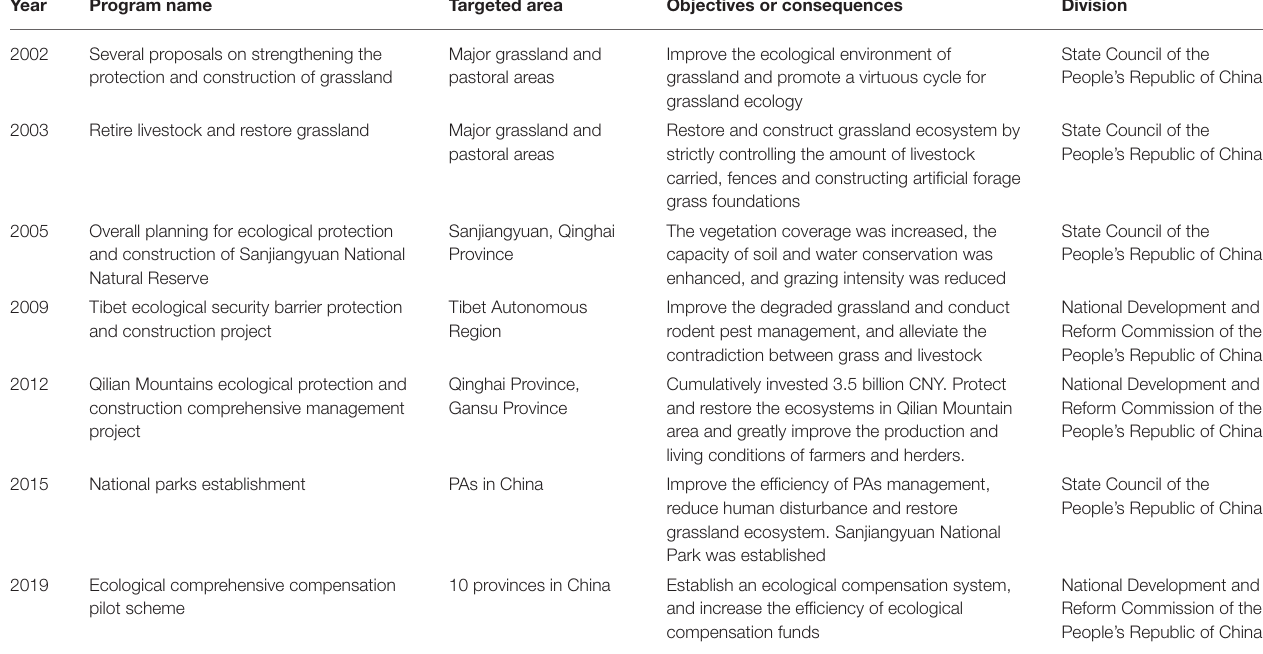
TABLE 1 | Diverse ecological protection and construction